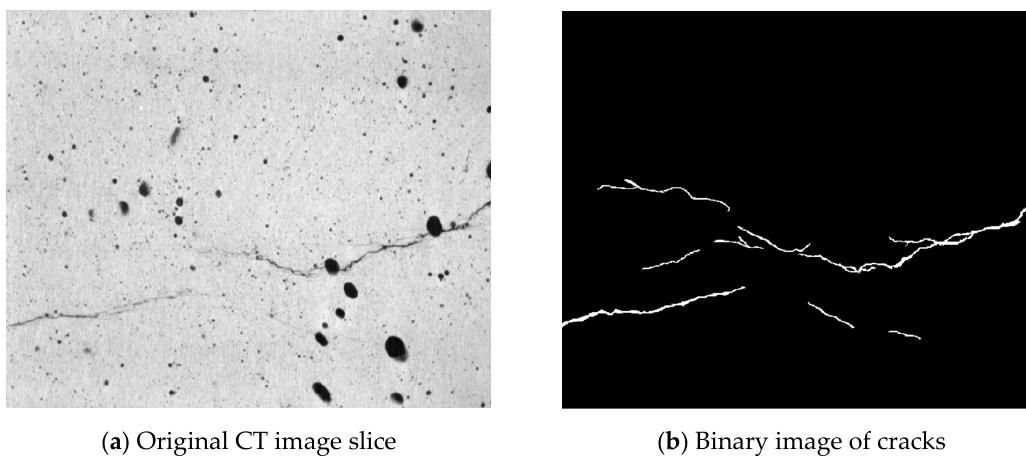
Figure 16. Crack recognition by processing computed tomography (CT) image slices.